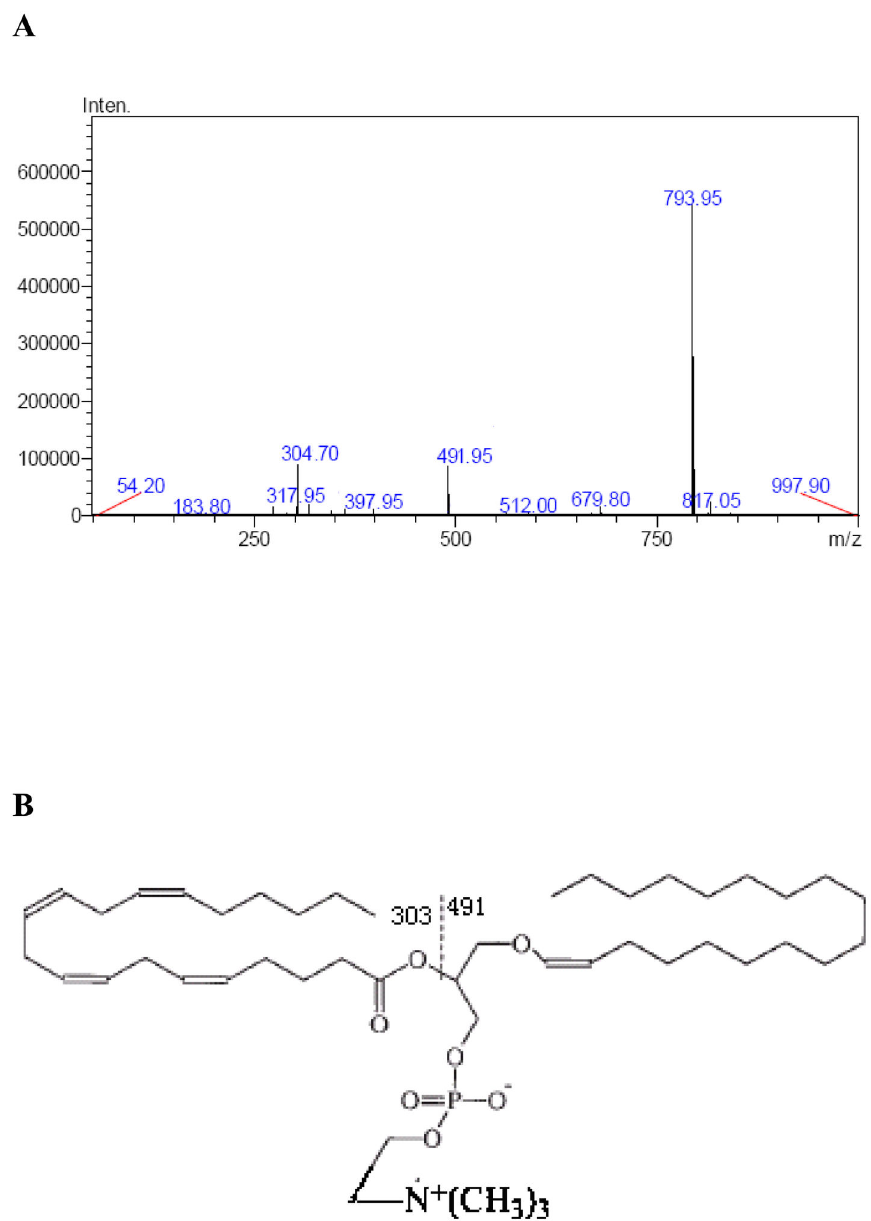
Figure 2. Structure Identification of ChoPlas. A , Molecular characterization of ChoPlas on the MS/MS spectrum . The mass spectrum of swine liver ChoPlas in positive mode. Elution was performed as in Figure 1. Observed ions correspond to [M+H]+ (m/z 793.95) and ions resulting from fragmentation at the sites indicated in the structure formula of the [M+H]+ anion; B , Structure of the identified ChoPlas